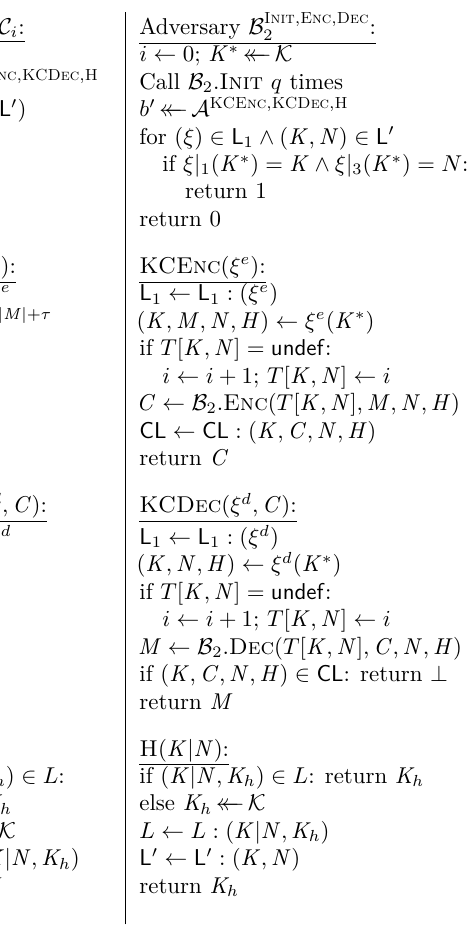
Figure 10: On the left is the description of adversary B 1 simulating the challenger of A in the KC-AE game whilst interacting in the MUAE environment. In the middle is the description of adversaries C i simulating the oracle requests by A in the KC-AE game when b = 0 and whilst running in the key unpredictability environment. On the right is the code for an adversary B 2 simulating A in the KC-AE game whilst interacting in the MUAE